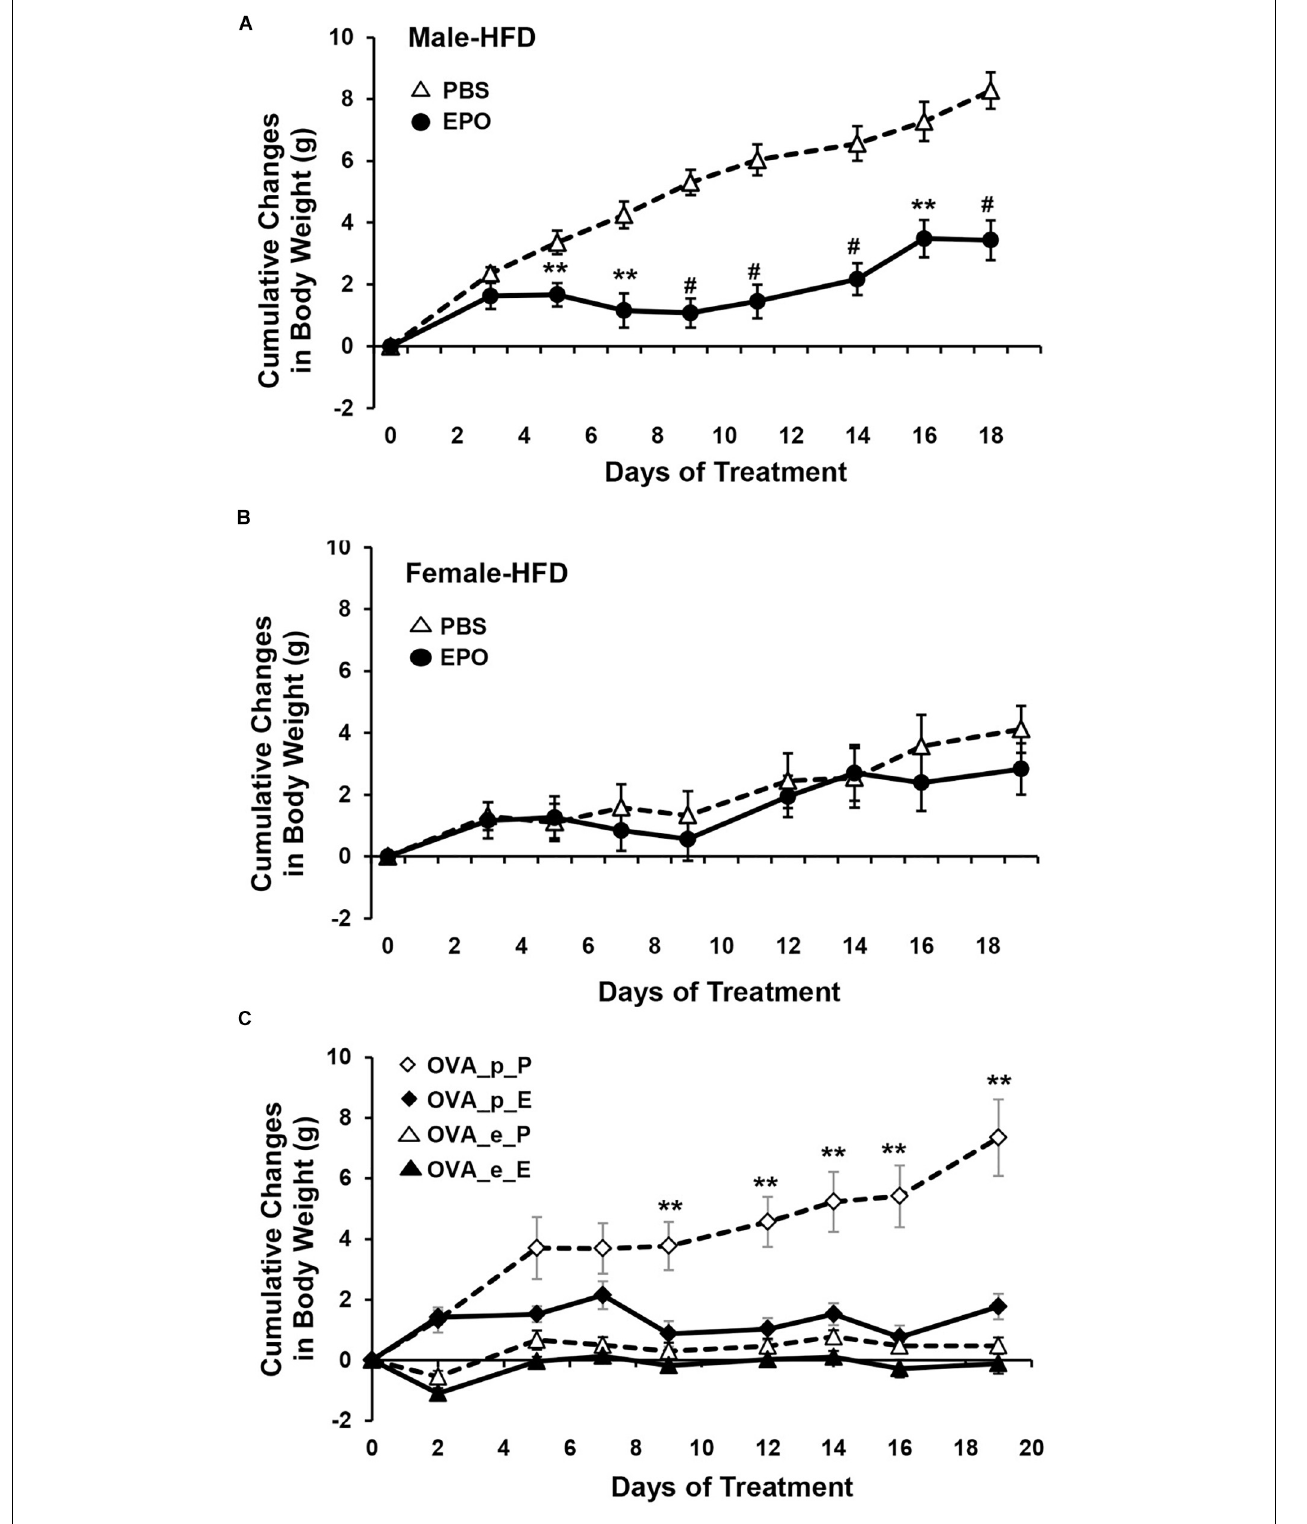
FIGURE 4 | EPO regulation of fat mass is gender specific. (A,B) Cumulative body weight change was monitored in male (A) and female (B) mice (16 weeks) fed high fat diet and treated with EPO at 3000 U/kg three times weekly (solid symbol) or saline (open symbol) for 3 weeks. (C) Cumulative body weight change in female ovariectomized (OVA) mice with placebo (p) or estradiol pellet-supplement and treated with EPO (E) or phosphate-buffered saline (P). ∗∗ p < 0.01; # p < 0.001 (from Zhang et al., 2017, with permission).